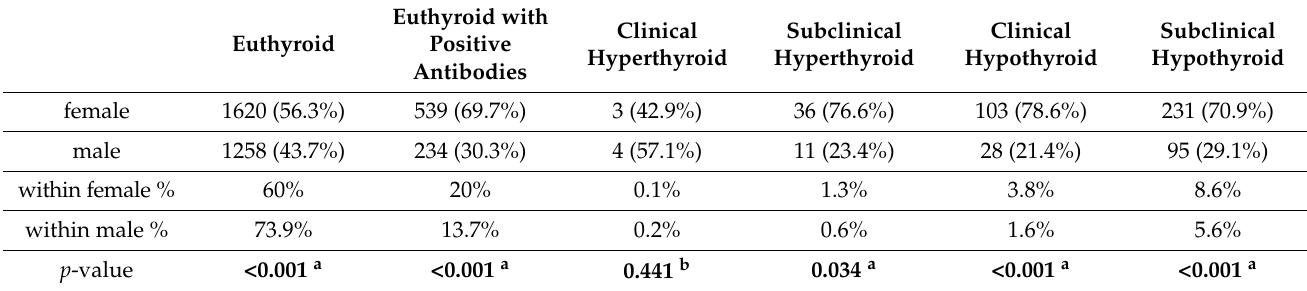
Table 3. Distribution of gender across thyroid function groups.